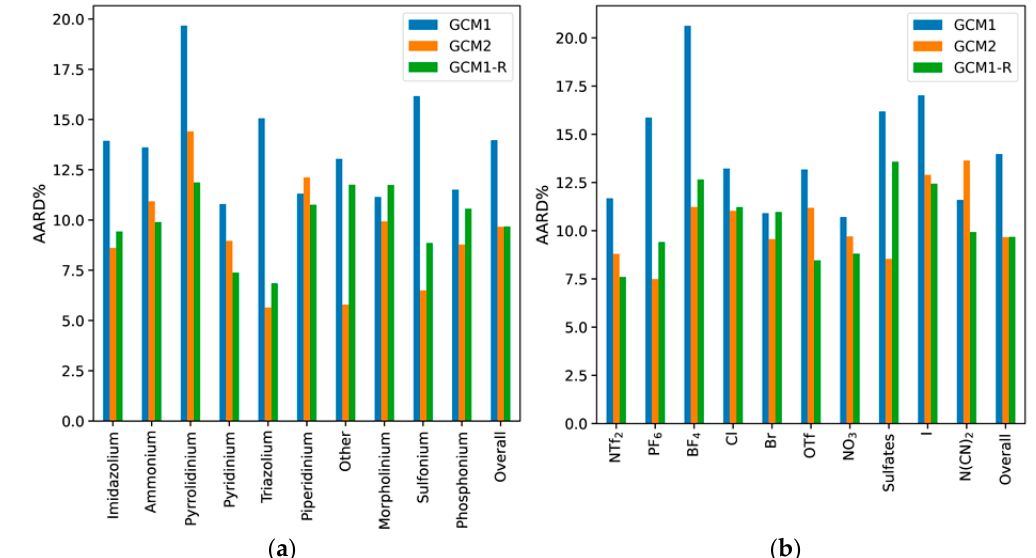
Figure 7. Comparison of AARD for GCM1-R with GCM1 and GCM2 for the estimation of IL melting point according to ( a ) cation type and ( b ) anion type.